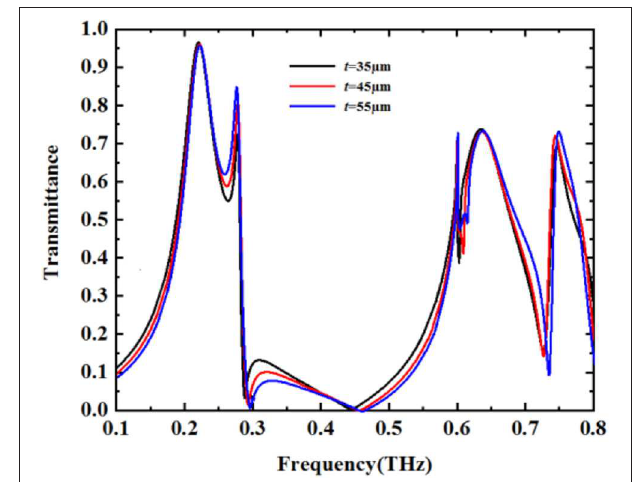
FIGURE 2 | Transmittance spectra of the proposed crossing fractal-air-crossing fractal structure for various values of a .